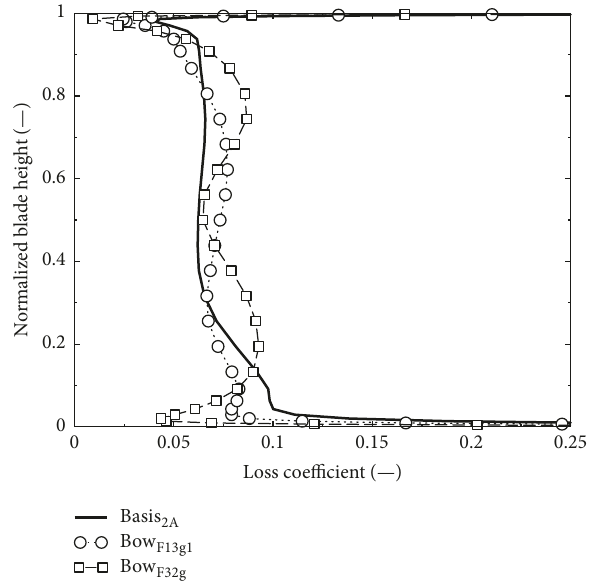
Figure 12: Circumference averaged loss distributions of the stators over the channel height.